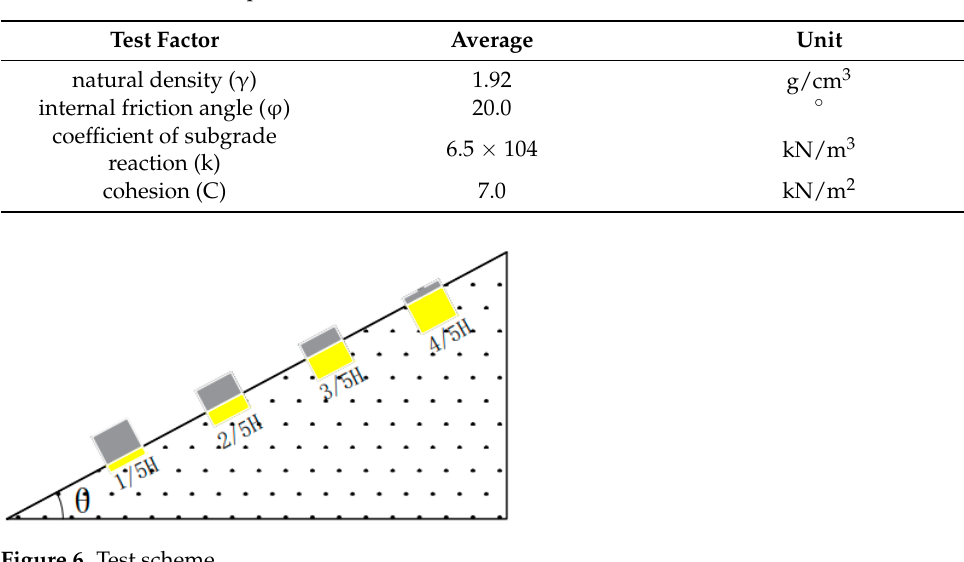
Figure 6. Test scheme.